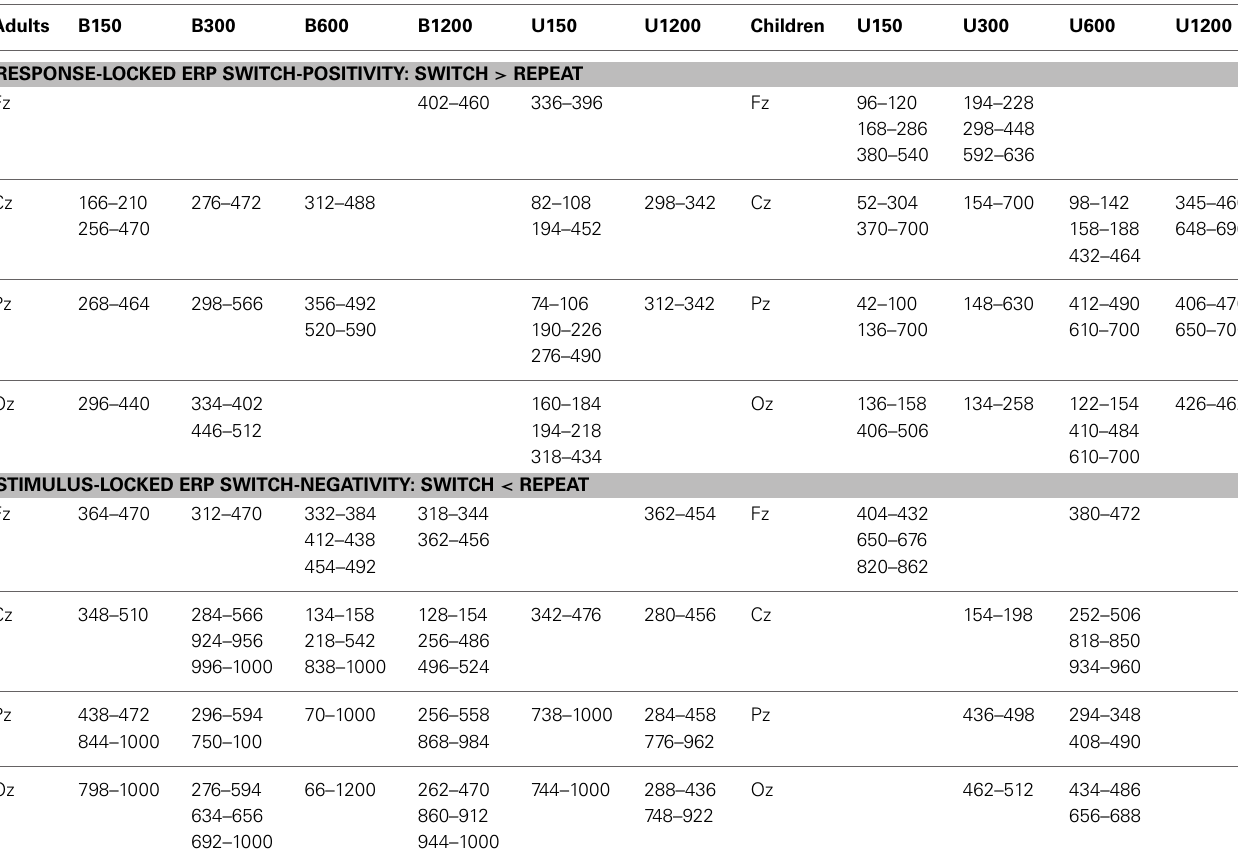
Table 1 | Areas of significant deviation from baseline for the switch-positivity in response-locked ERPs and the switch-negativity in stimulus-locked ERPs for Experiments 1 and 2 [ p < 0 . 05 after correction using (Guthrie and Buchwald, 1991) criteria, see Methods for more